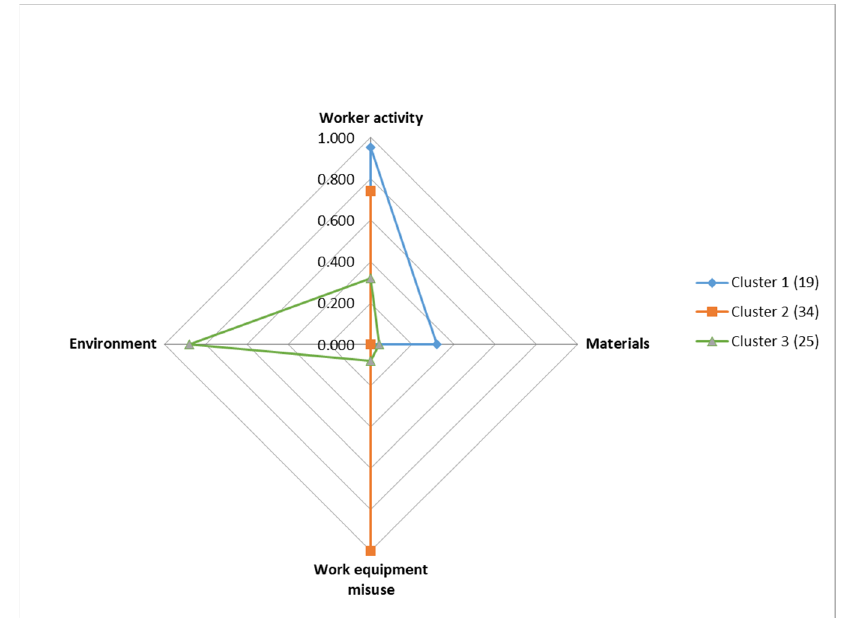
Figure 4. Result of the three-cluster solution.